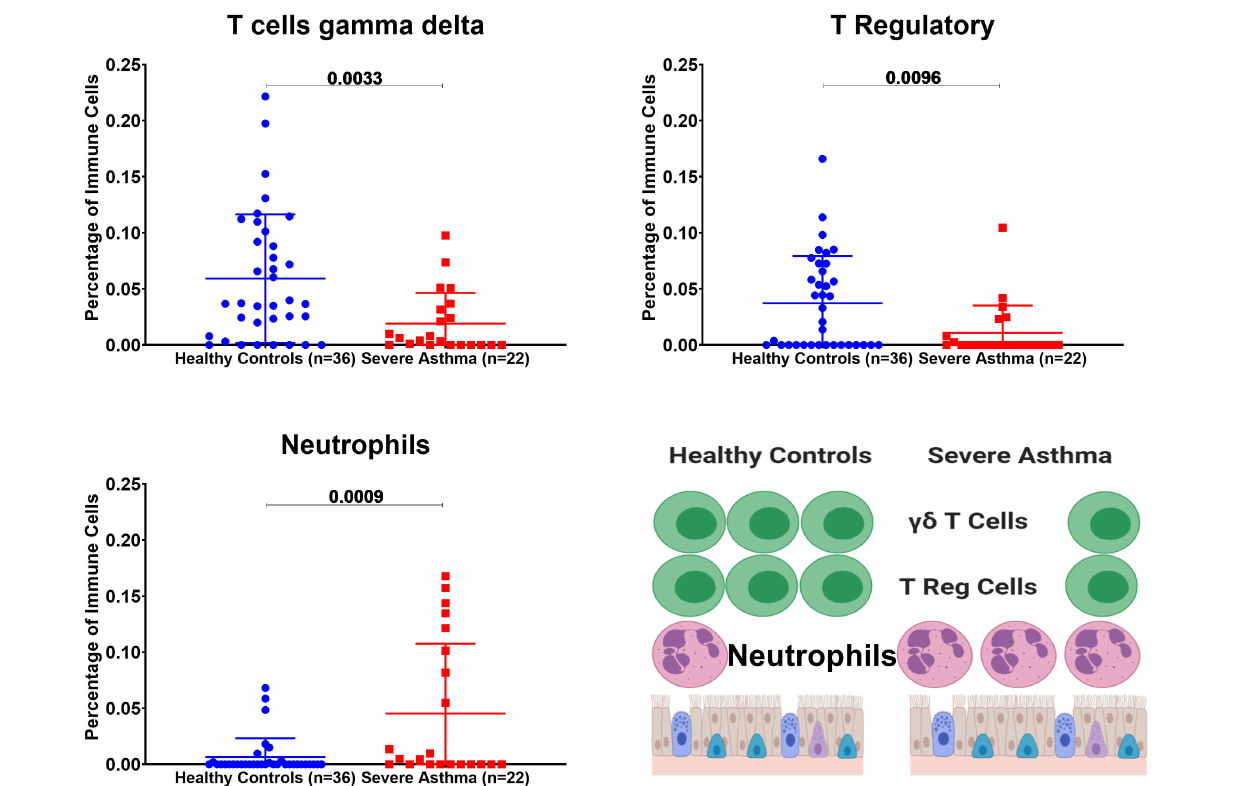
FIGURE 8 | Estimating immune cells populations in the bronchial epithelium of (c3SE64913) dataset in healthy controls ( n = 36) compared to severe asthmatics ( n = 22). Bronchial epithelium genes expression was loaded to CIBERSORT in silico flow cytometry.